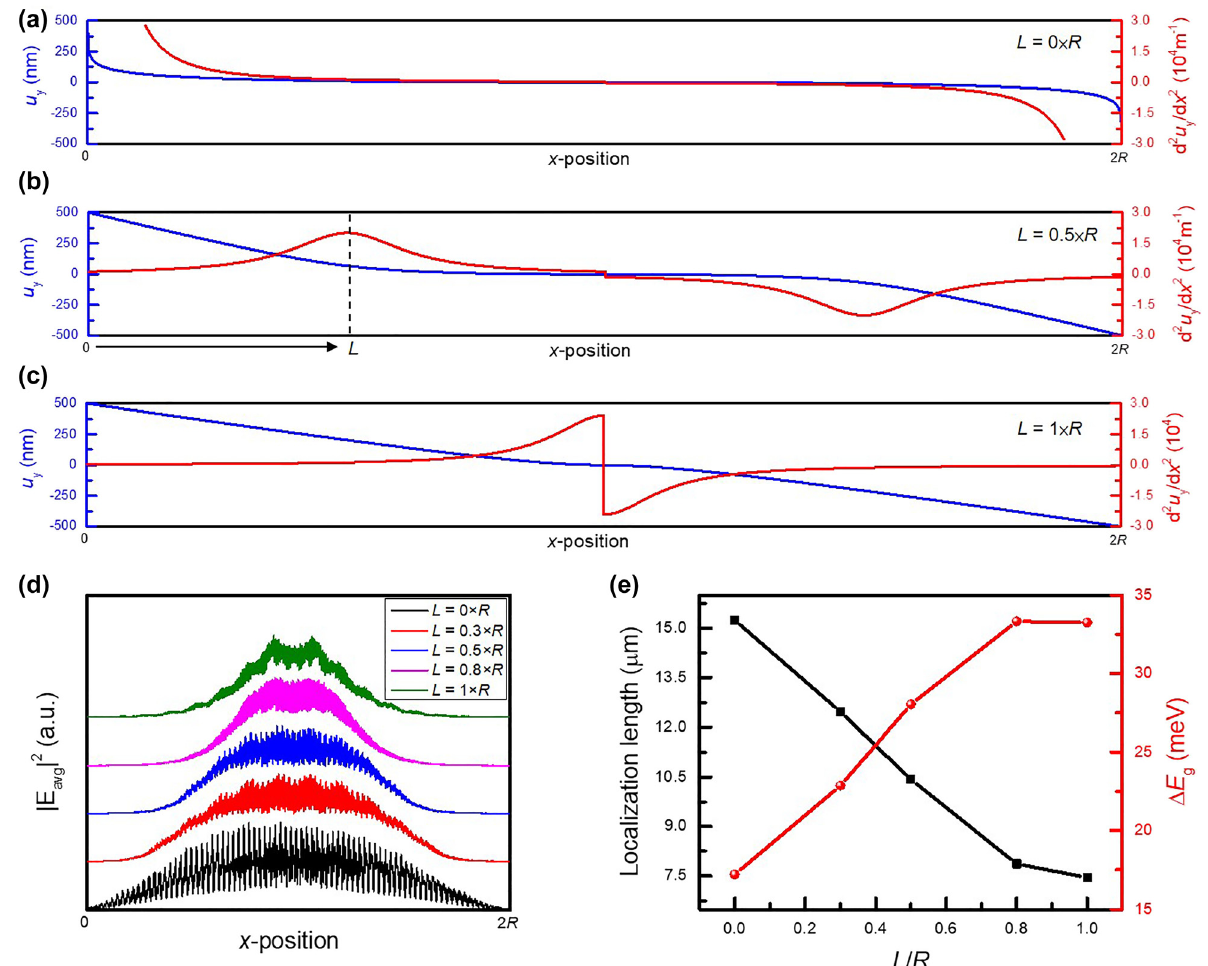
Figure 6: The tunability based on the peak position of the pseudo-magnetic field. (a) – (c) The continuous displacement function in different peak position of the pseudo-magnetic field, including L = 0 (a), 0.5 × R (b), and 1 × R (c).(d)The | E avg | 2 oftopologicaledgestate σ + in L =0 × R ,0.3 × R ,0.5 × R ,0.8 × R ,and1 × R .(e)Themodelocalizationand Δ E g asthefunctionof LR